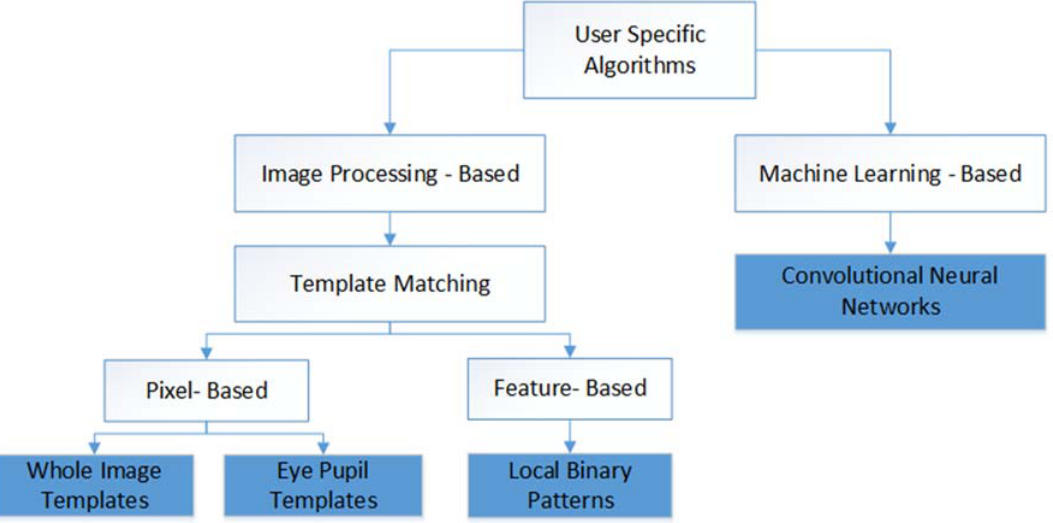
Figure 6. Classification of algorithms for gaze estimation.